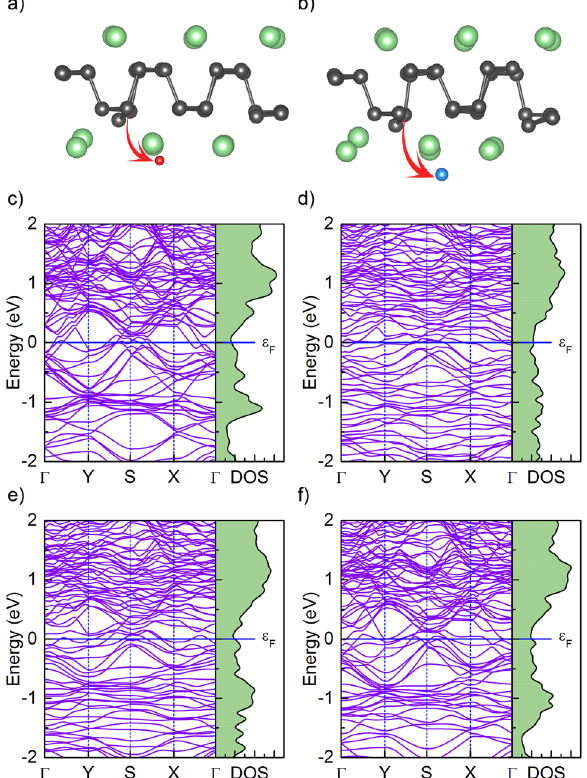
Figure 5. Structural deformation of the ( a ) F- and ( b ) Cl-doped phosphorene lattice at the adsorption of Mg atoms. The gray and green spheres represent P and Mg atoms, respectively. Red arrows indicate the dopants (F and Cl atoms marked with red and blue balls, respectively) pulled out of the plane during the structure optimization. Electronic band structure and density of states of fully Mg covered phosphorene sheet with ( c ) B-, ( d ) Sc-, ( e ) Co-, and f) Cu-substitution in place of one P atom.